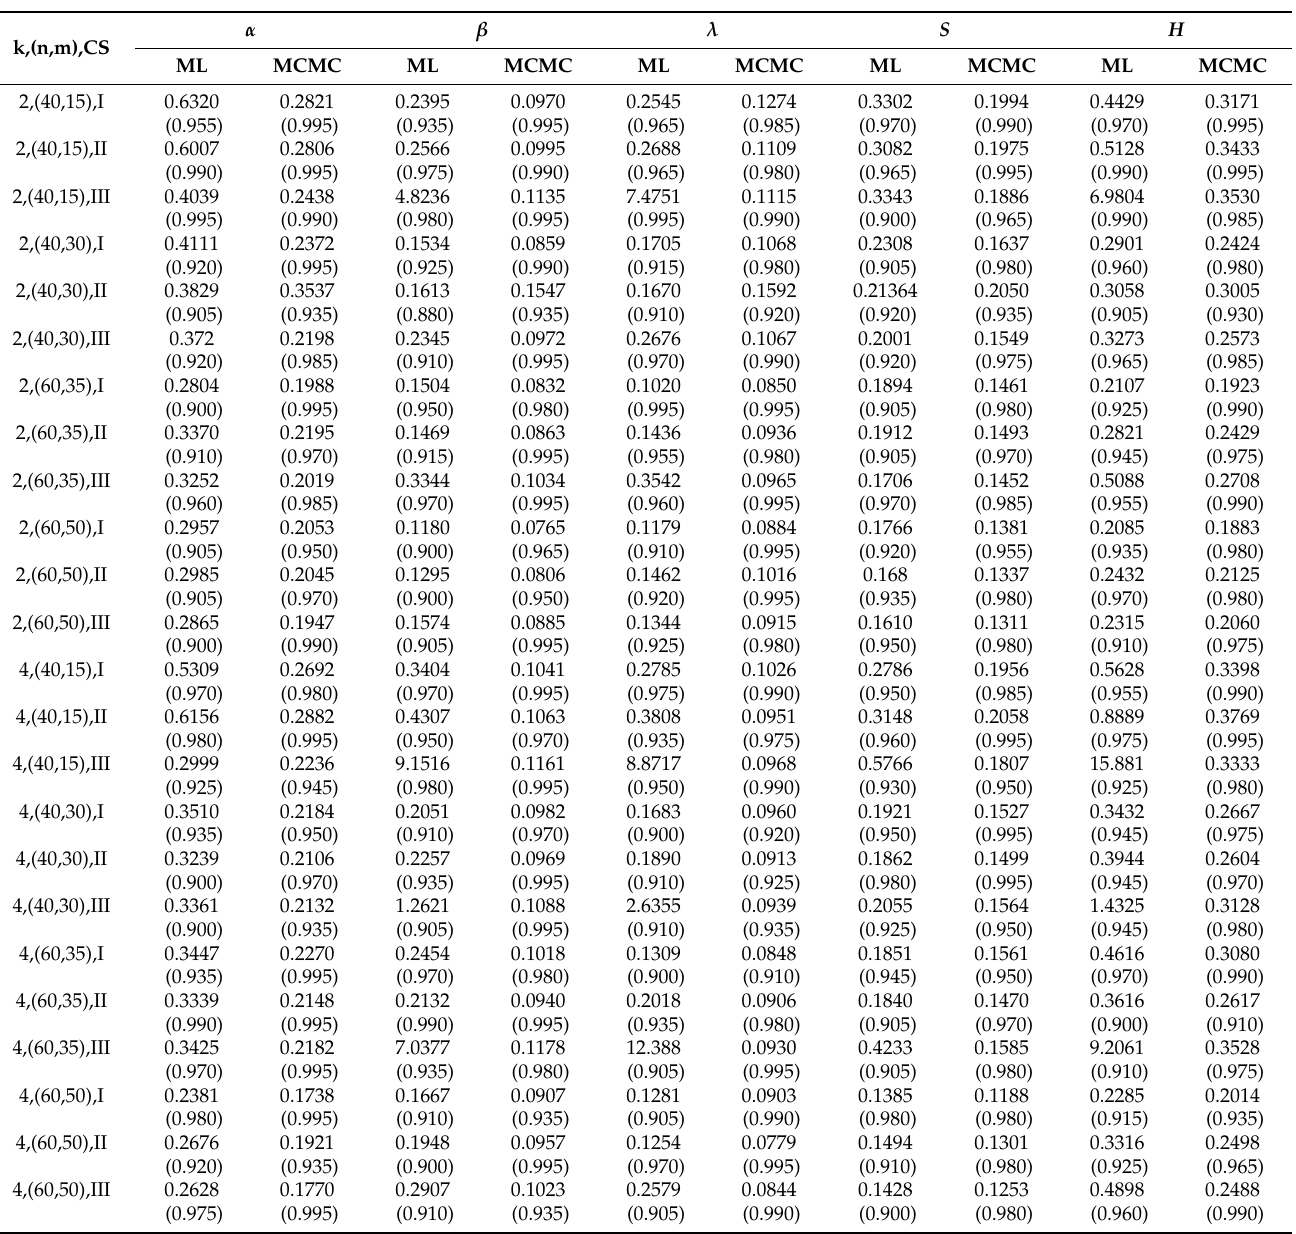
Table 5. AW and (CP) of 95%